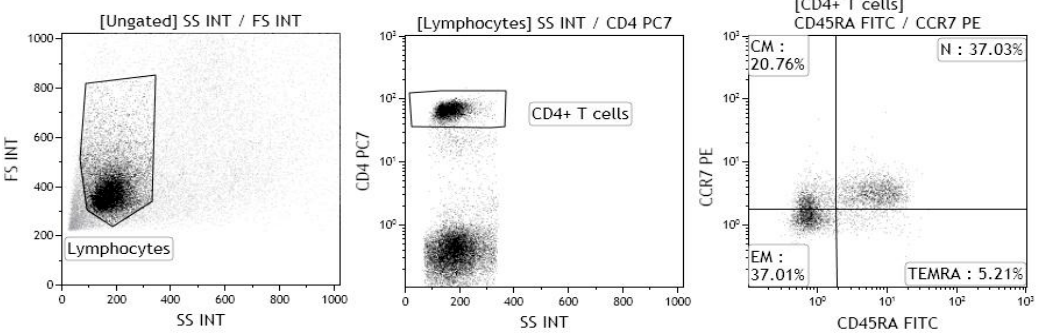
Figure 7. Gating strategy for the identification of naïve CD4 + T lymphocytes (N), central memory CD4 + T lymphocytes (CM), effector memory CD4 + T lymphocytes (EM) and terminally differentiated effector memory (TEMRA) CD4 + T lymphocytes. The lymphocyte population was gated on forward and side scatter properties, and further gated for CD4, CCR7, CD45RA expression; at least 20,000 events were acquired within the CD4 gate. The samples were acquired using a Gallios flow cytometer, and the data were analysed using Kaluza software (both Beckman Coulter).